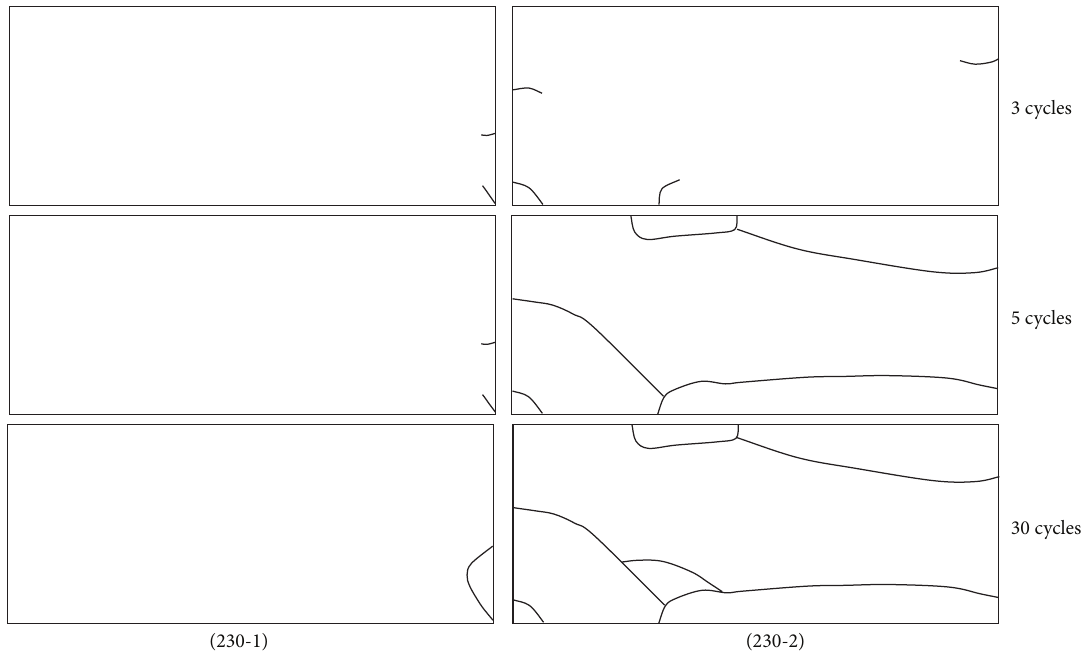
Figure 6: Cracks cartography on the normal face of grades 230-1 and 230-2 after cyclic thermal shocks at Δ𝑇 = 23 0 ∘ C. [2, 3, 17, 18], to the relaxation of compressive stresses.